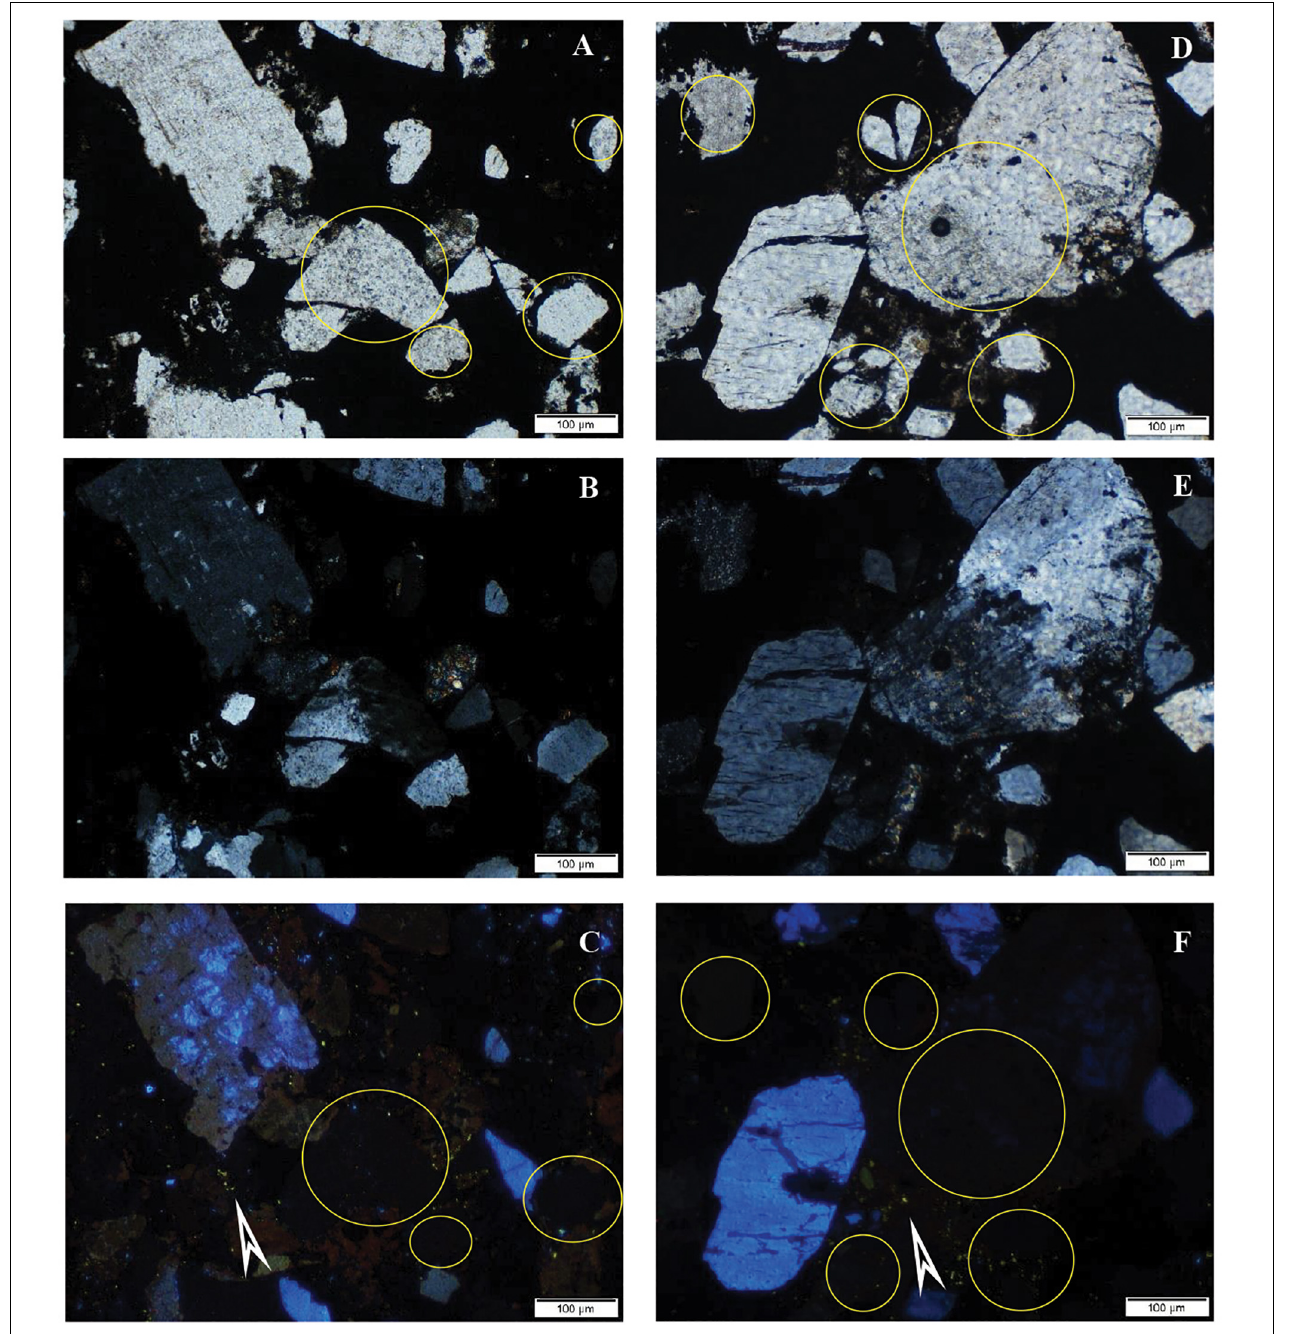
FIGURE 7 | Typical cathodoluminescence images of sample COR-10. Bright blue luminescence is characteristic of feldspar and kaolinite group-dickite (supported by Raman spectroscopy, Götze et al., 2002), bright yellow minerals are small apatite grains (arrows), transmitted light photos by 1N (A,D) , crossed N (B,E) , and CL images of the same area of sample (C,F) . Circles show clastic-like but non-luminescent mineral grains.